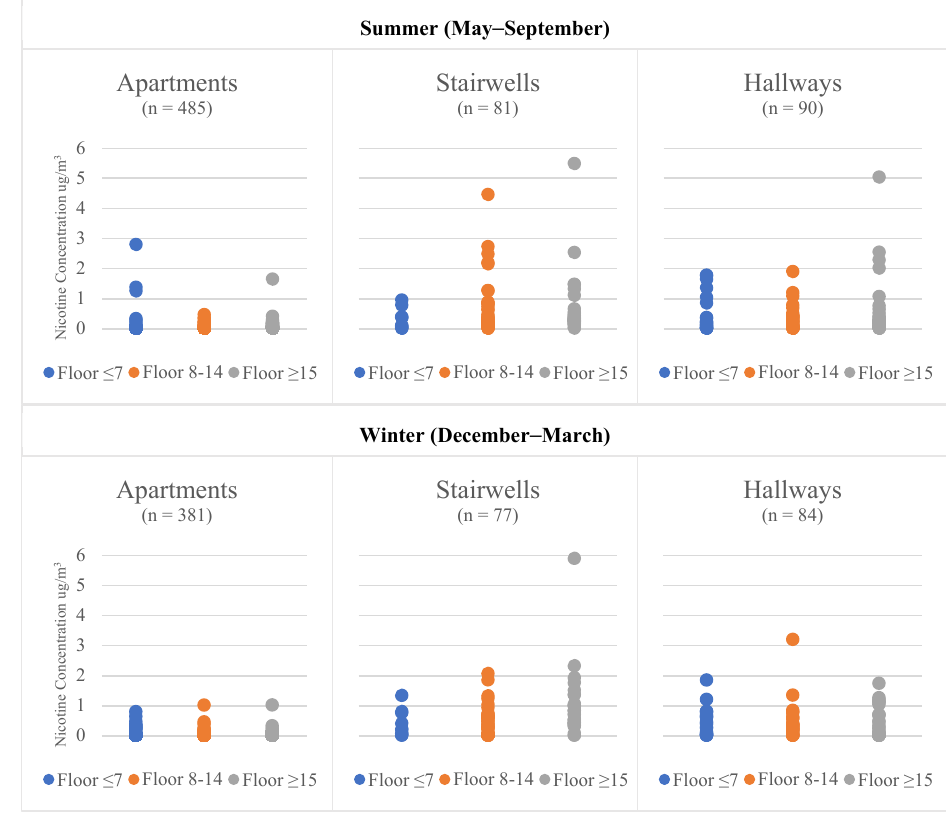
Figure 1. Variance in Air Nicotine Concentration by Location and Season.